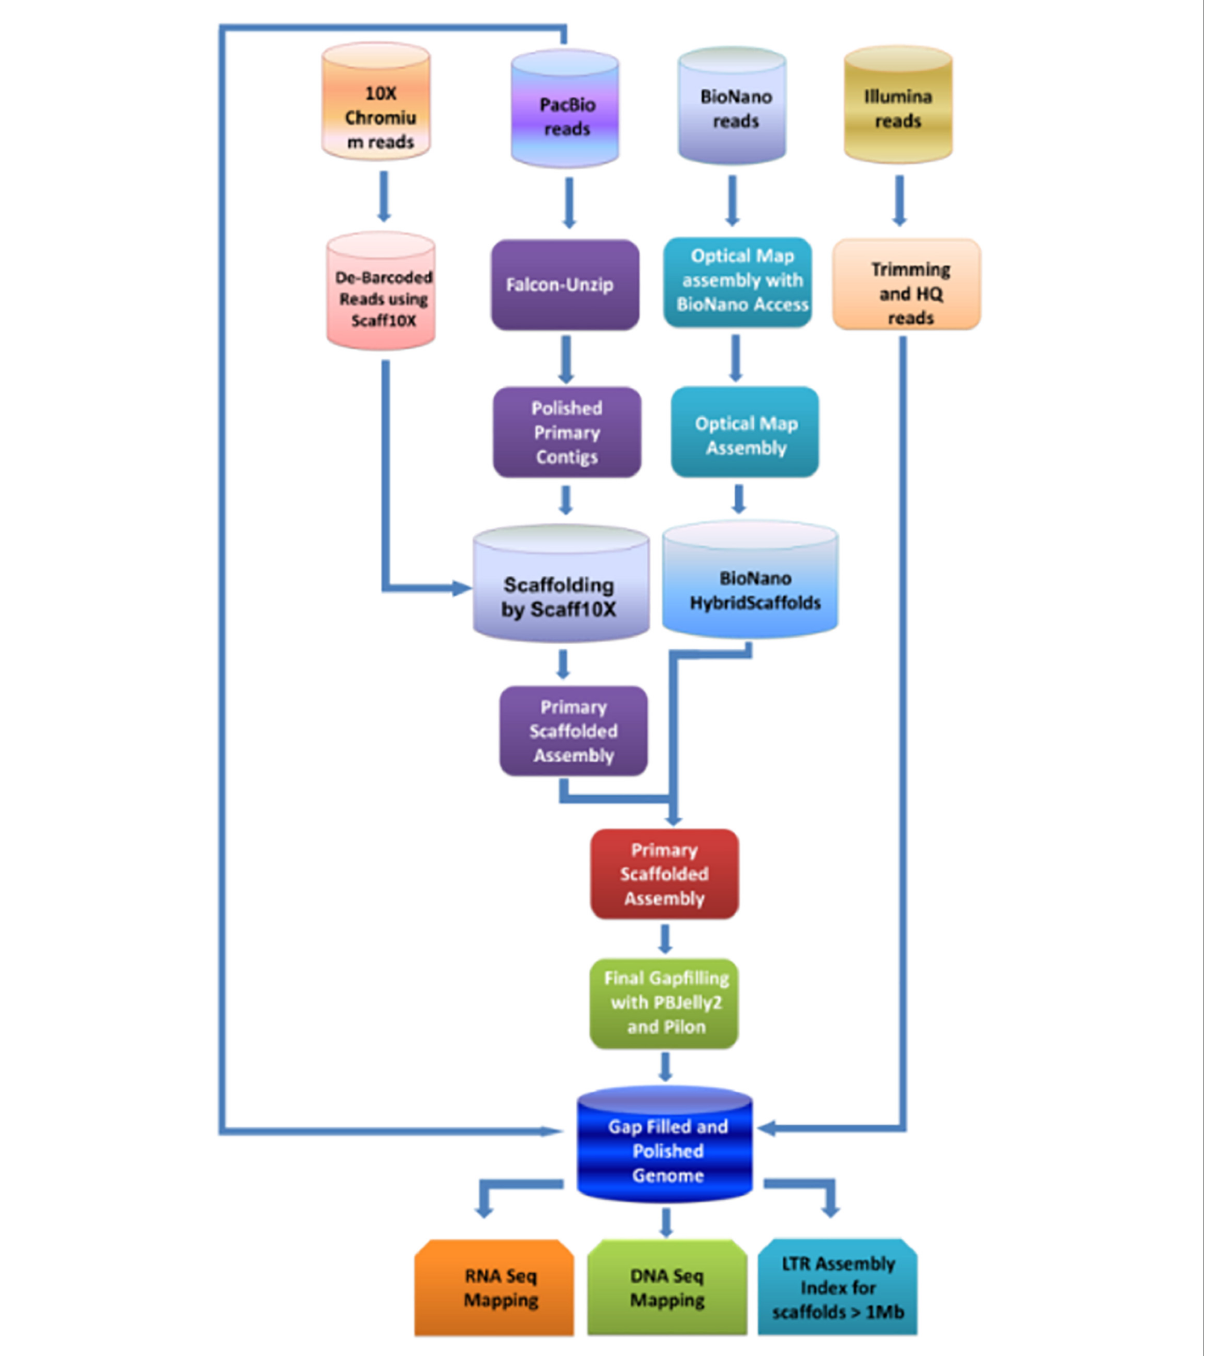
FIGURE1 Flow diagram of the strategy used for assembling the genome of pomegranate cv. ‘ Bhagawa’.